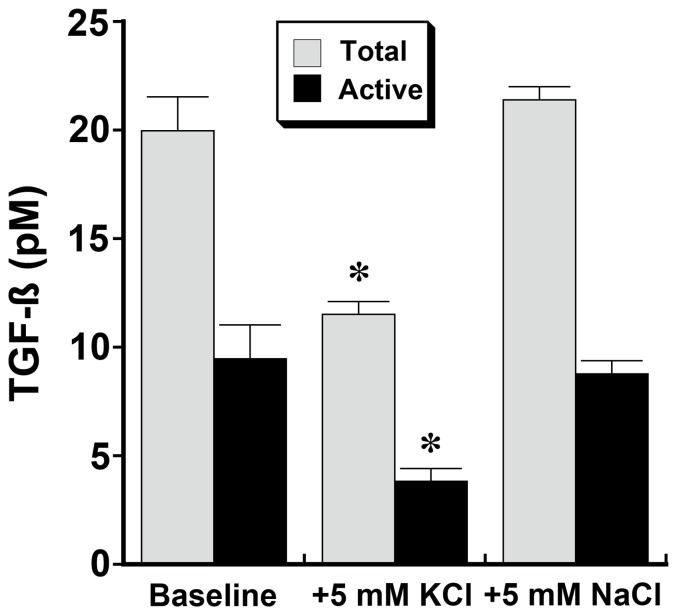
Medium [KCl] affects endothelial cell production of total and active TGF-ß.Medium concentrations of total and active TGF-ß were determined following overnight incubation in medium that contained [KCl], 0 mM, (termed Baseline), and in medium supplemented with 5 mM of either KCl or NaCl. Addition of KCl, but not NaCl, decreased production of both total and active TGF-ß. *p-value <0.05 compared to the other two groups. n = 6 experiments in each group.